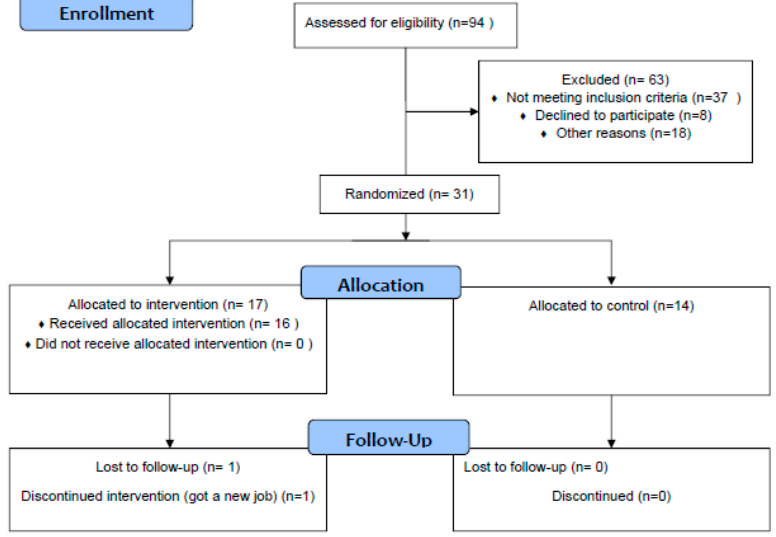
Figure 1. CONSORT 2010 Flow Diagram.